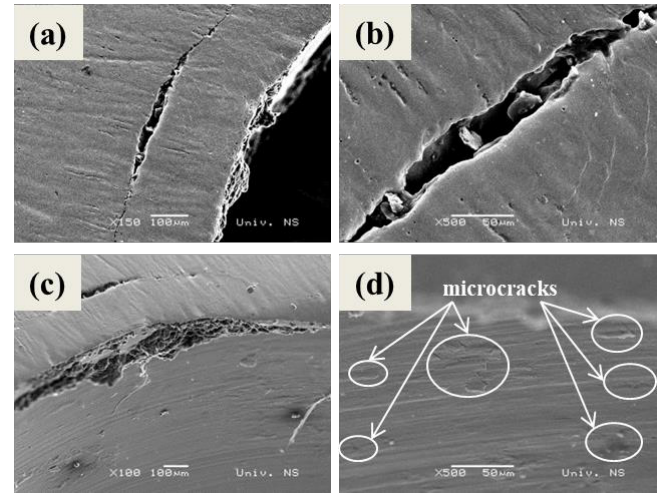
Figure 11. Micrographs after tensile test of untreated material ( a – d ).